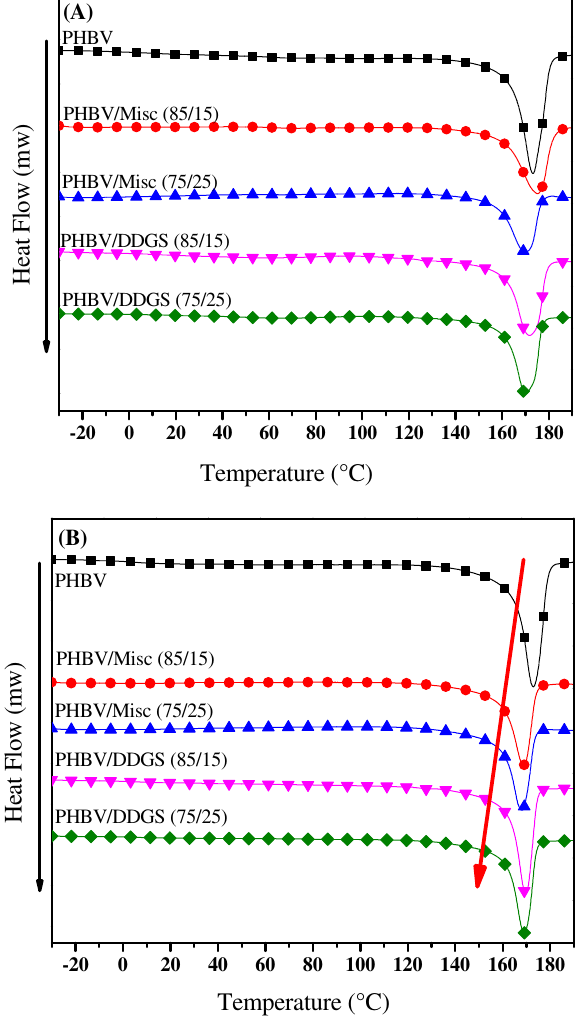
Figure 2. DSC ( A ) first heating cycle, and ( B ) second heating cycle of PHBV, PHBV/Misc and PHBV/DDGS